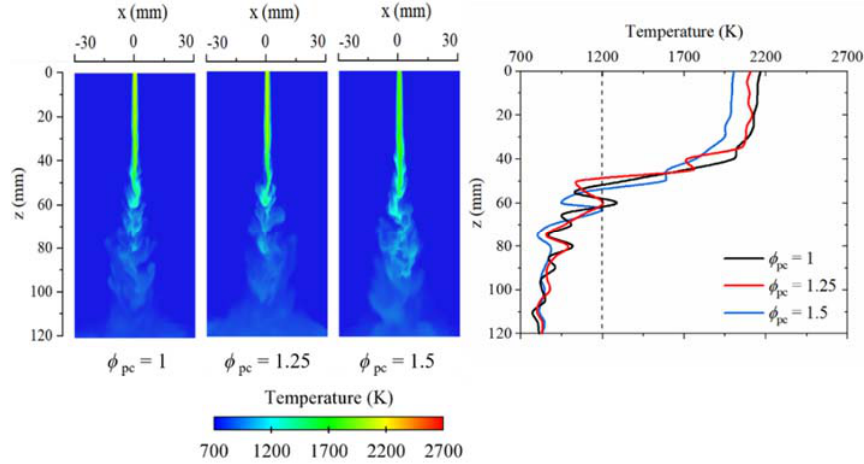
Figure 12. Distribution of jet temperature and centerline temperature traces for different prechamber global equivalence ratios at 3 ms after the hot jet appeared.